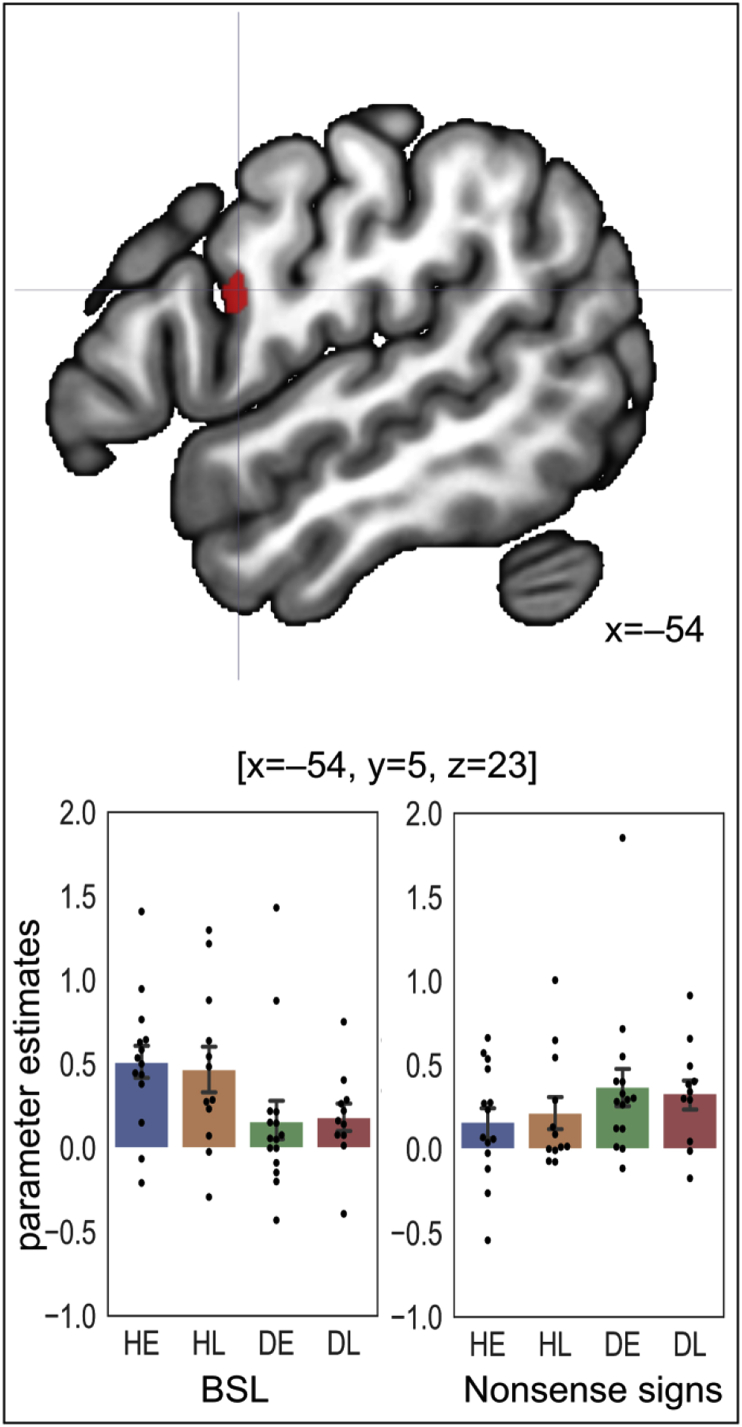
The interaction between hearing status and stimulus type in the left precentral gyrus at [x ​= ​−54, y ​= ​5, z ​= ​23]. Top row: the effect is shown at p ​< ​.05 FWE corrected. Bottom row: bar plots showing the parameter estimates at this peak for BSL on the left, strings of nonsense signs on the right. Each data point is also displayed as a black dot. Error bars indicate standard errors.